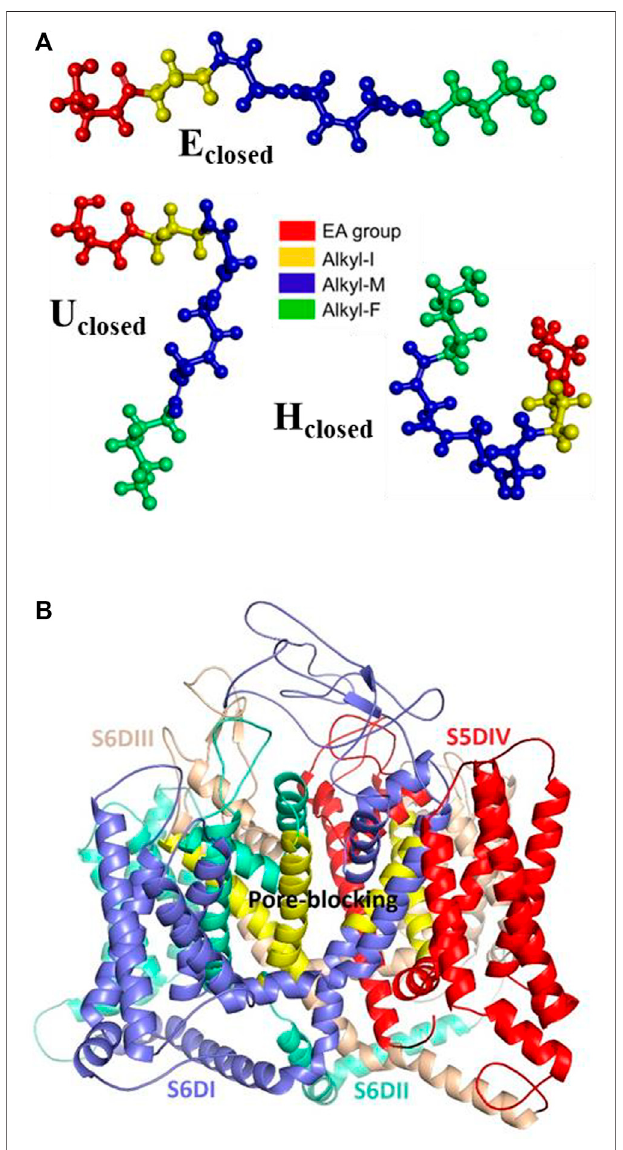
FIGURE 3 | Molecular structures. (A) Anandamide conformers E closed , U closed , and H closed , and (B) Ca v 3.2 channel showing the main interacting